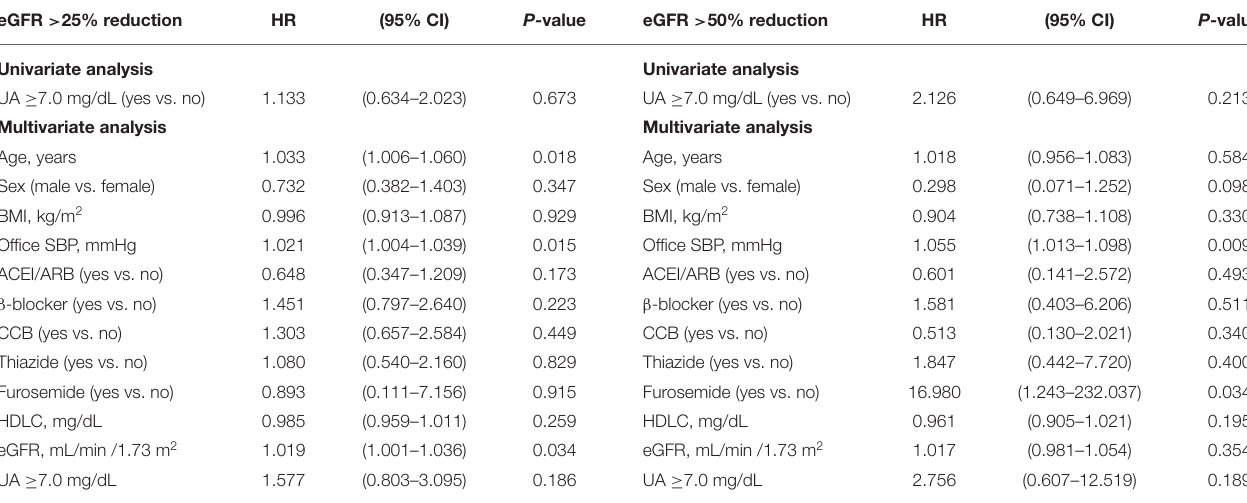
TABLE 8 | Uric acid 7.0 mg/dL and decline of estimated glomerular filtration rate (eGFR). eGFR > 25%